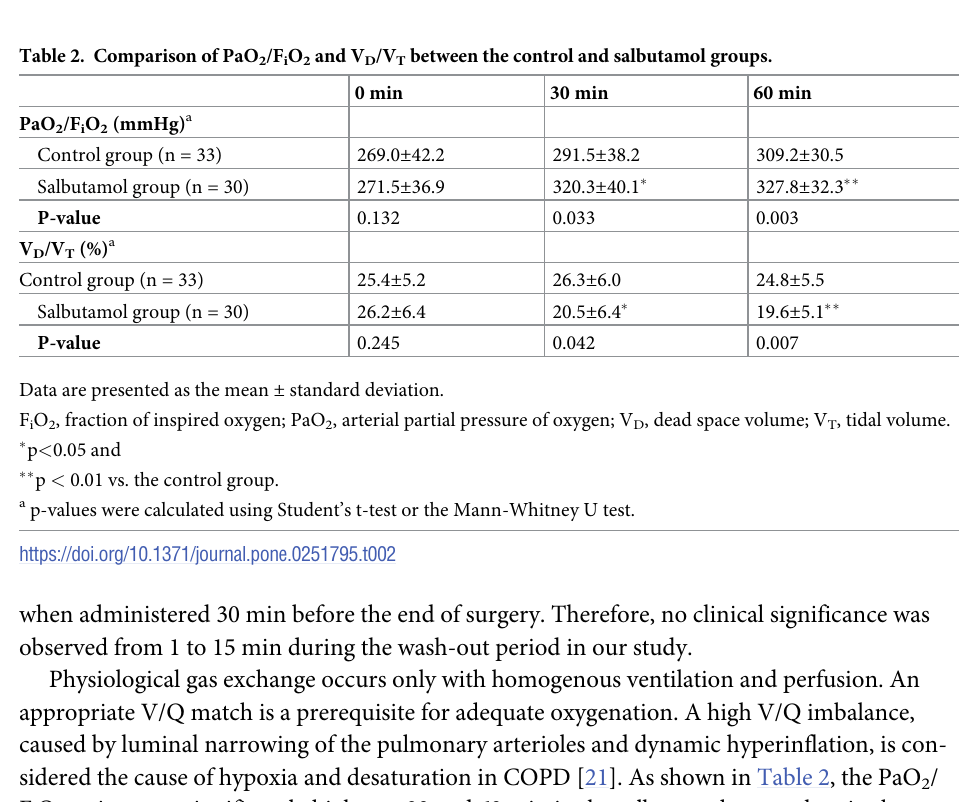
Table 2. Comparison of PaO 2 /F i O 2 and V D /V T between the control and salbutamol groups. 0 min 30 min 60 min